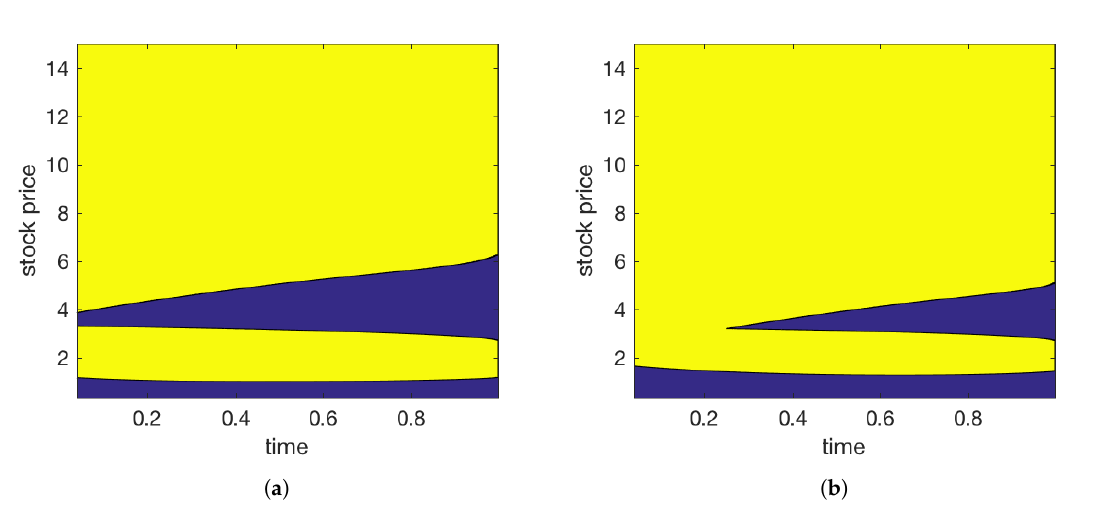
Figure 6. Optimal trading regions for stock liquidation under the double exponential distribution. The continuation regions are in yellow (light) color and the exercise regions are in blue (dark), and they are disconnected. Parameters for ( a ): θ = 0, λ 1 = λ 2 = 4.714, p 1 = p 2 = 0.5; parameters for ( b ): θ = 0, λ 1 = λ 2 = 3.536, p 1 = p 2 = 0.5. Common parameters: X 0 = 1, r = 0.1, ¯ T = 1, T = 1.1, σ =